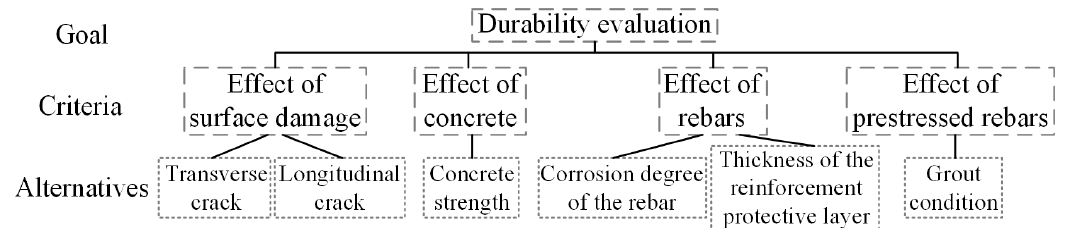
Figure 12. Hierarchical structure of the durability evaluation.